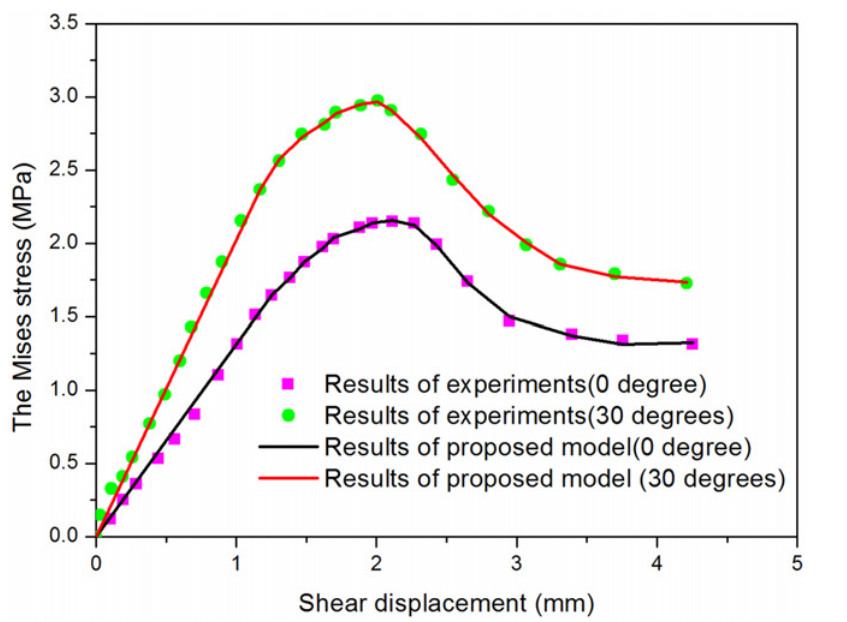
Fig 12. Curves of shear stress-displacement of experiment and numerical